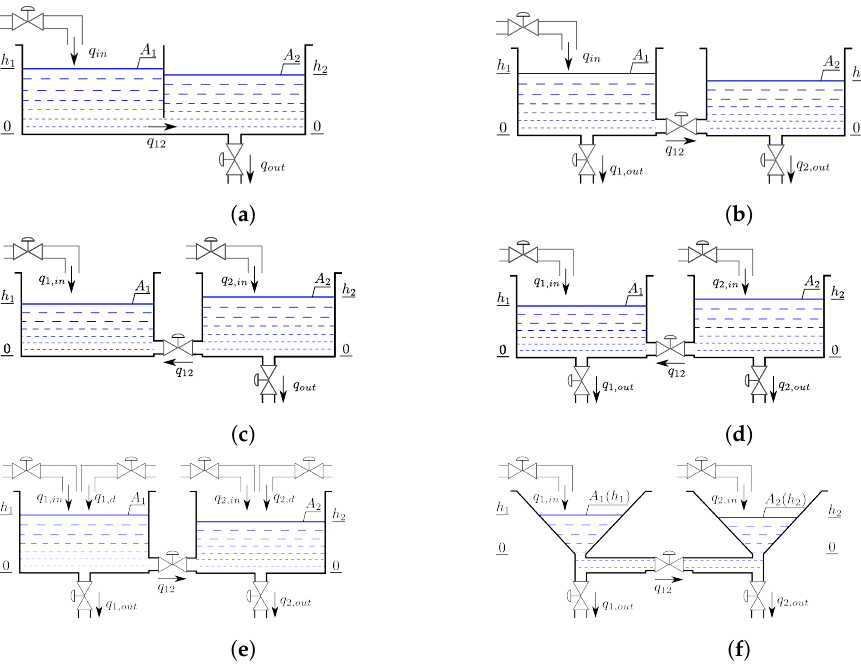
Figure 2. Various physical models of coupled two-tank configurations. ( a ) One control inlet and outlet. ( b ) One control inlet and two outlets. ( c ) Two control inlets and one outlet. ( d ) Two control inlets and two outlets. ( e ) As in ( d ), with two disturbance signals. ( f ) As in ( d ), with a conical